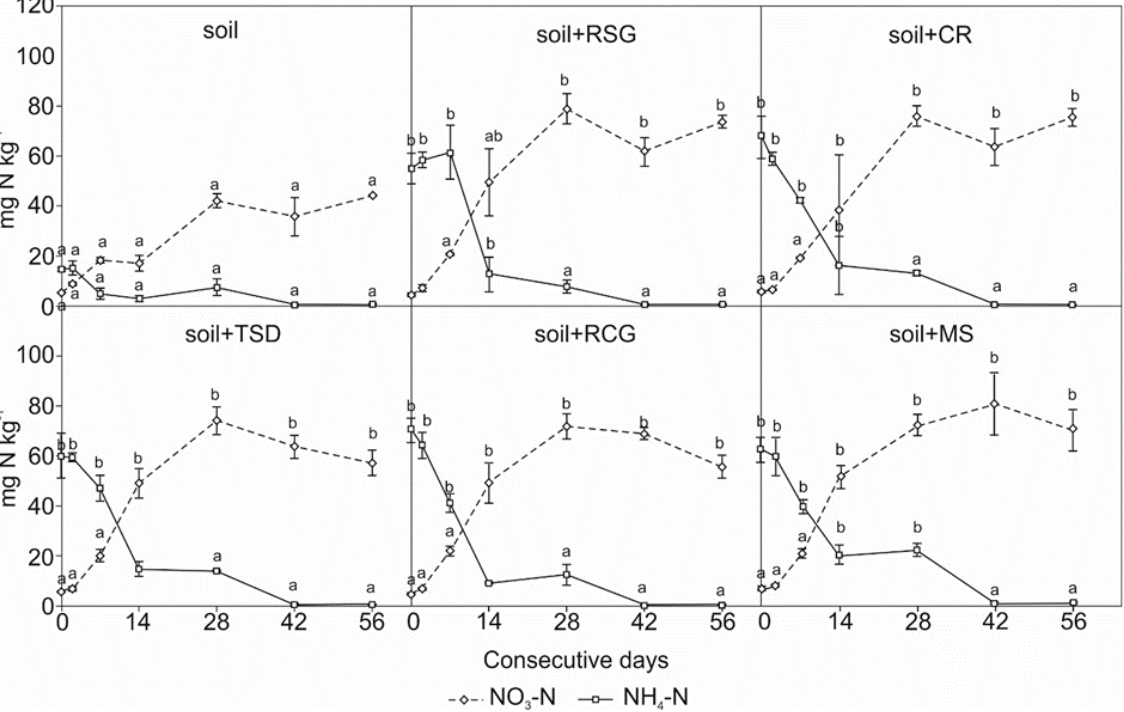
Figure 1. NO 3 -N and NH 4 -N dynamics during the incubation experiment (mean value ± standard deviation, where absent, bars fall within symbols) in the control (soil) and in soils treated with reed sweet-grass digestate (RSG), common reed digestate (CR), tufted sedge digestate (TSD), reed canary grass digestate (RCG) and maize digestate (MS). At the same time point, different letters indicate significant differences (p < 0.05) in means according to Tukey’s